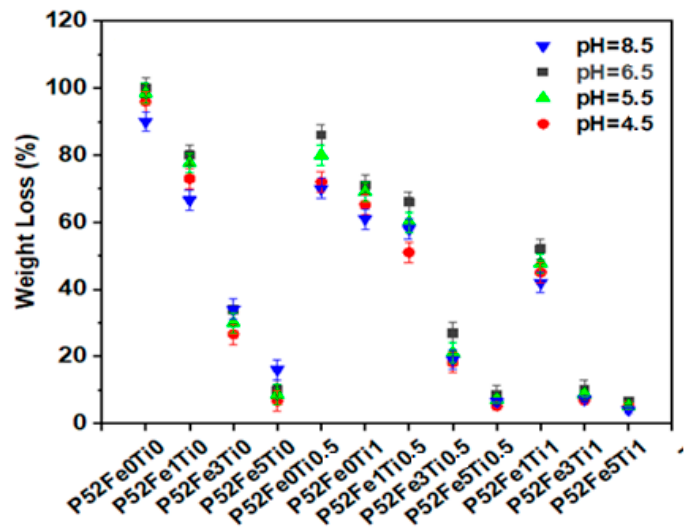
Figure 3. Weight loss Percentage of Phosphate glass fibers in an aqueous medium.